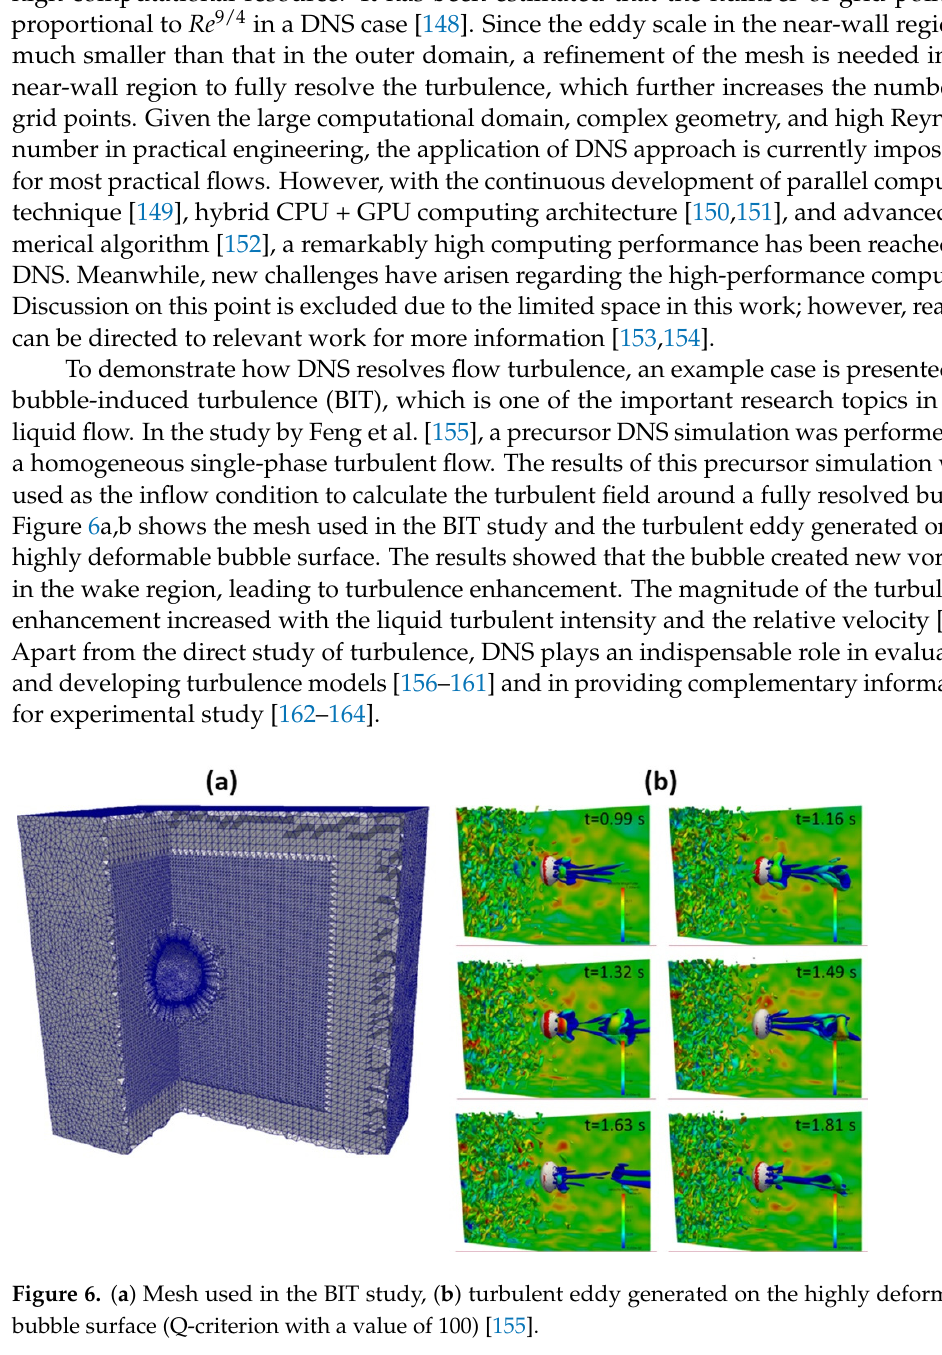
Figure 5. Wall shear stress for the inclined wall ( Cf : wall shear stress, x / δ : normalized distance from the start of the incline) [144].